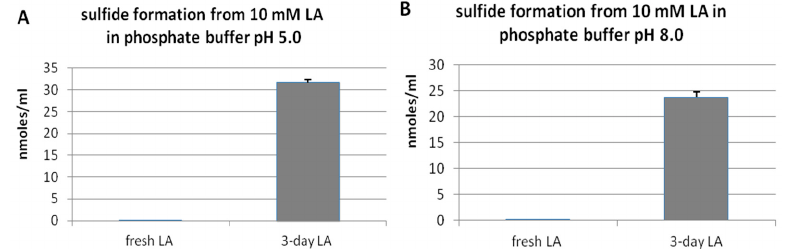
Figure 1. Level of hydrogen sulfide formed in vitro from fresh lipoic acid (LA) or from LA left for three days unprotected from light at pH 5.0 ( A ) or 8.0 ( B ). The results are presented as the means ± SD (standard deviation).